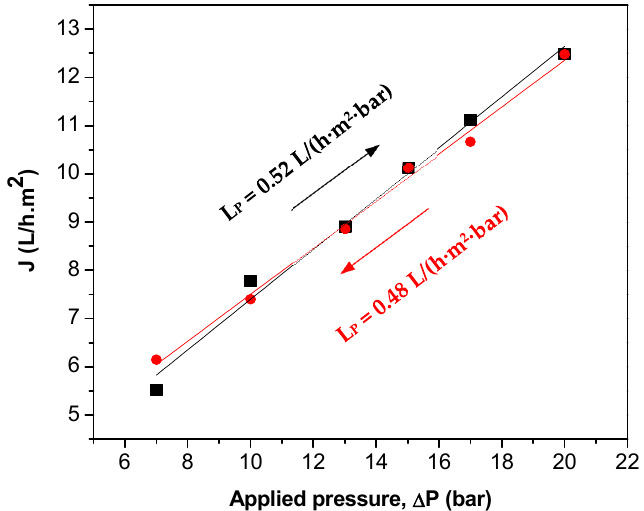
Figure 2. Permeate fluxes, J, obtained during filtration of acidic water (pH 3.6) at increasing (squares) and decreasing (circles) pressures using the cs-PES MF022 membrane before diafiltration. Lp repre- sents the hydraulic permeability of the membrane determined at increasing and decreasing